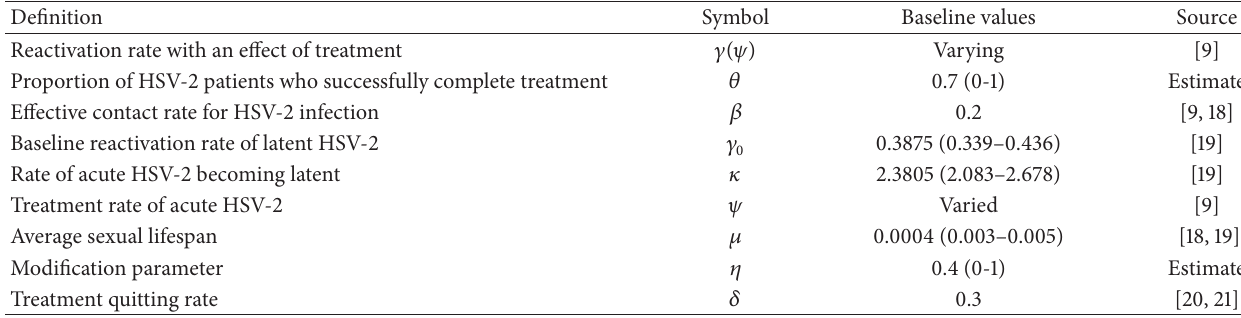
Table 1: Model parameters and their baseline values. The time unit is in